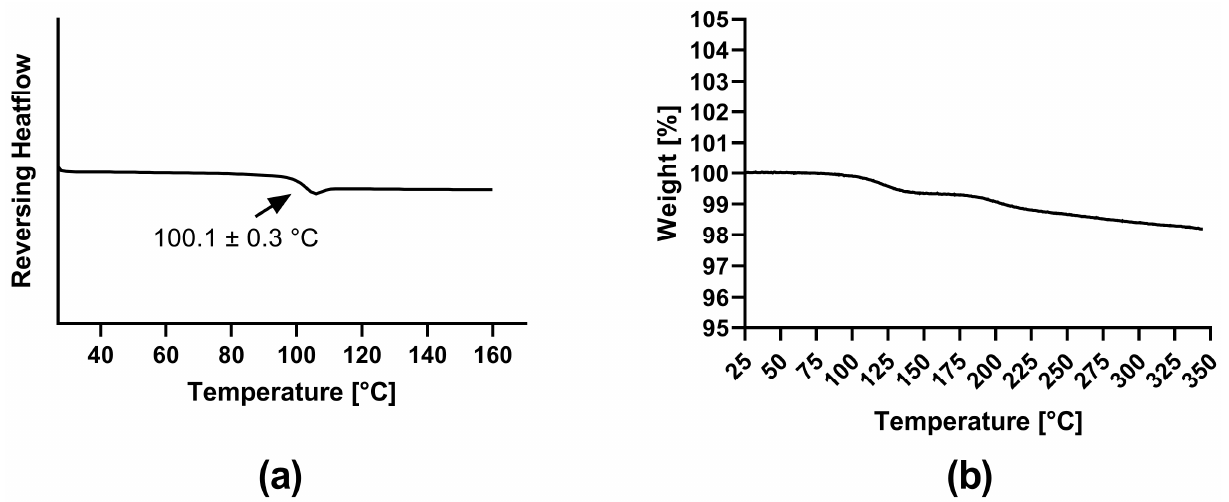
Figure 3. Solid state analysis of neat ARCC-4: ( a ) Differential scanning calorimetry (DSC) thermogram (exo up); ( b ) Thermogravimetric analysis (TGA).